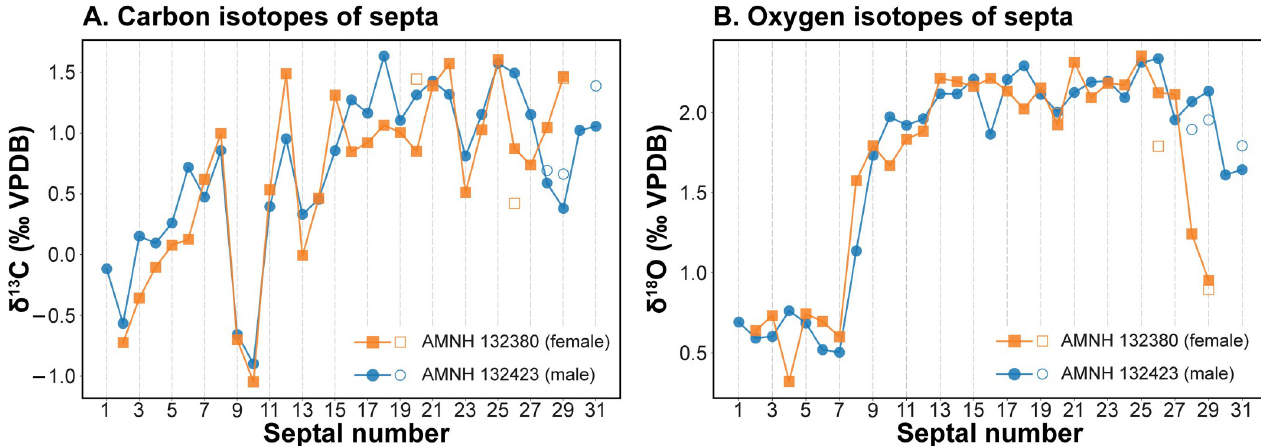
Fig 5. Septal C and O isotopes. δ 13 C (‰ VPDB) (A); δ 18 O (‰ VPDB) (B). Filled markers represent the data produced at the University of California, Santa Cruz. Unfilled markers represent the data produced at the University of Michigan.